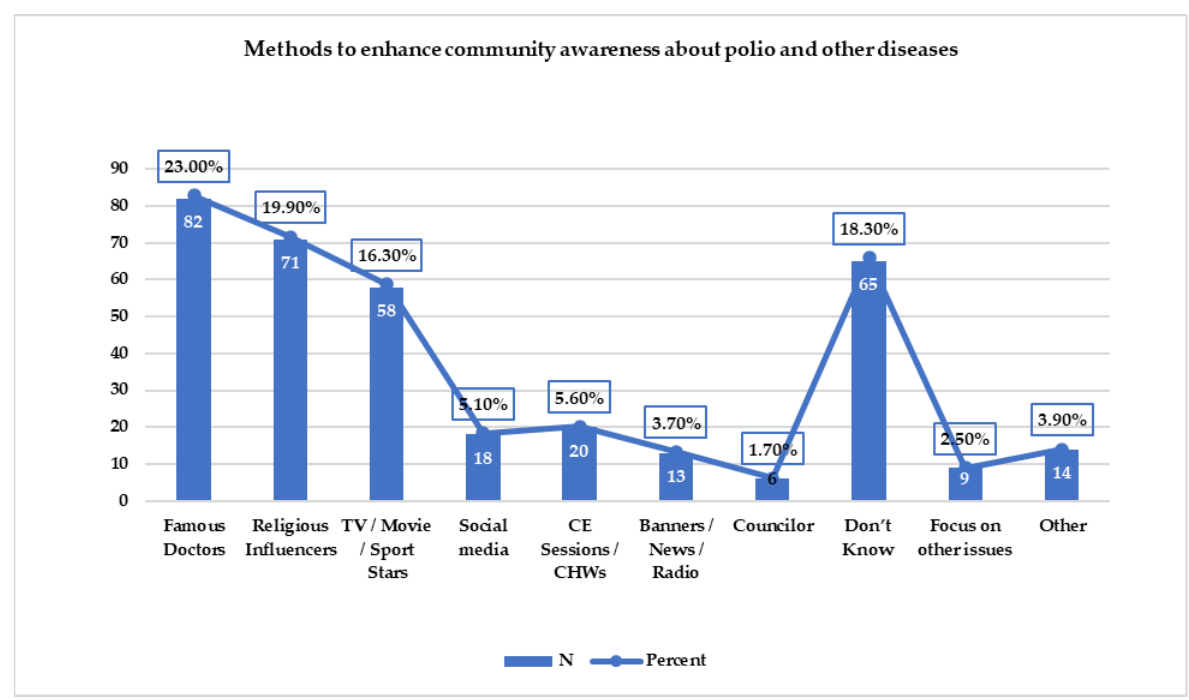
Figure 2. Suggestions from study participants on suitable ways to enhance community acceptance of polio vaccination campaigns in 34 high-risk union councils of Karachi division, Sindh,